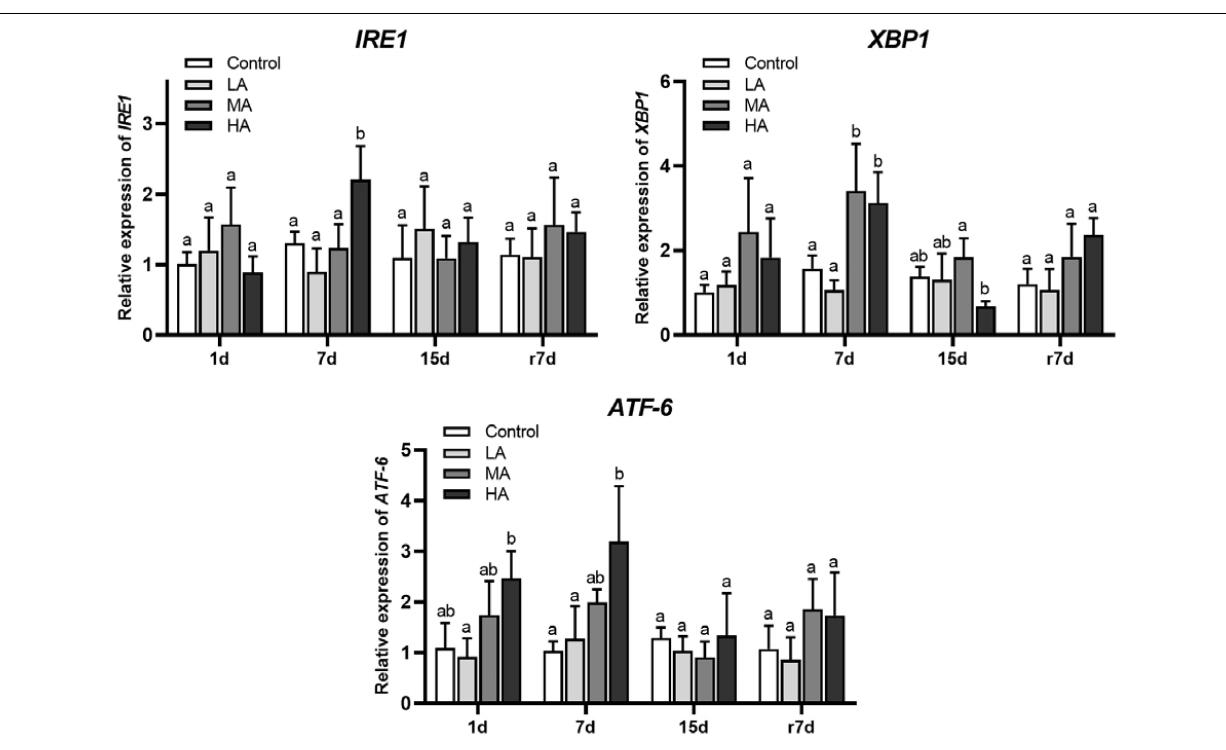
FIGURE 5 | The mRNA expression genes of UPR signaling in hepatopancreas of P. trituberculatus after ammonia exposure and recovery. Data are represented as mean ± S.D., n = 3, with P < 0.05 considered significant. Different letters represent significant differences among different